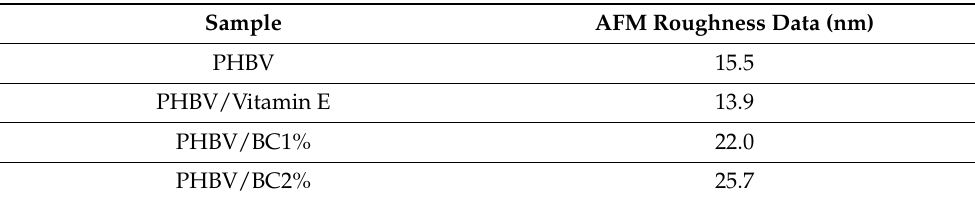
Table 2. Roughness values for the PHBV/BC biocomposites compared with PHBV evaluated from AFM